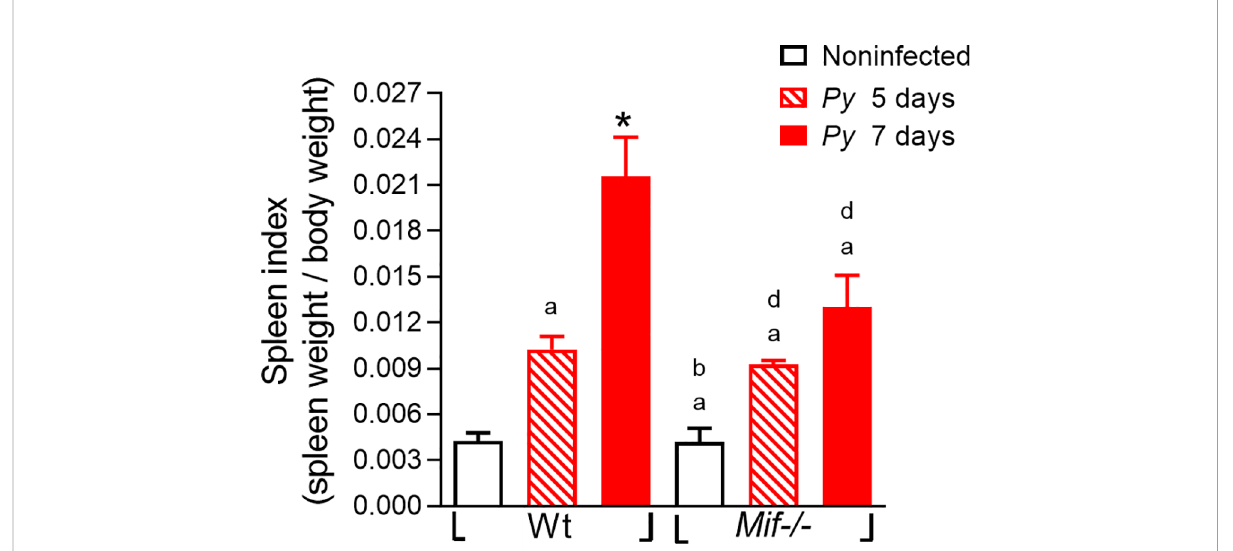
FIGURE 4 MIF de fi ciency reduces splenomegaly after Plasmodium yoelii 17XL infection. Wild-type and Mif-/- mice were infected with 1×10 3 Py 17XL- parasitized erythrocytes. Non infected Mif -/- and Wt mice were used as controls. The splenic index from infected Mif -/- and Wt mice at 5 and 7 days after Py 17XL infection. Data are expressed as the mean ± SEM and are representative of three independent experiments with at least 3 to 5 mice per group. Values of p < 0.05 were considered statistically signi fi cant, (a) compared with the noninfected Wt group, (b) compared with Wt group on day 5th post infection, (*) compared with all experimental groups, and (d) compared with the noninfected Mif -/-